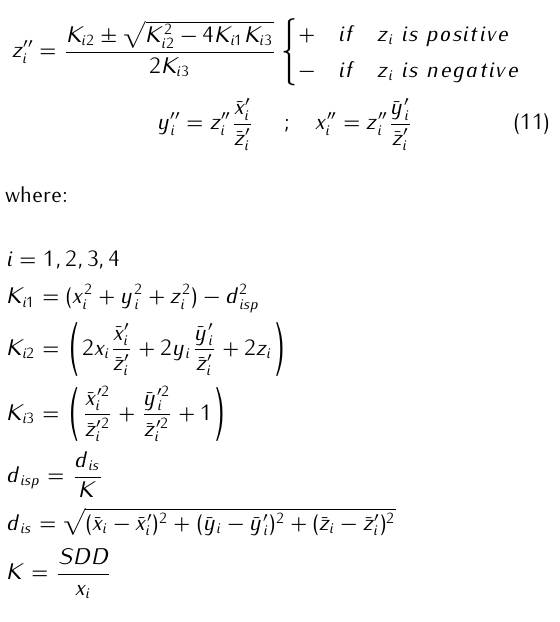
00 y 00 z 00 1 ¯ 1 ¯ 1 ,